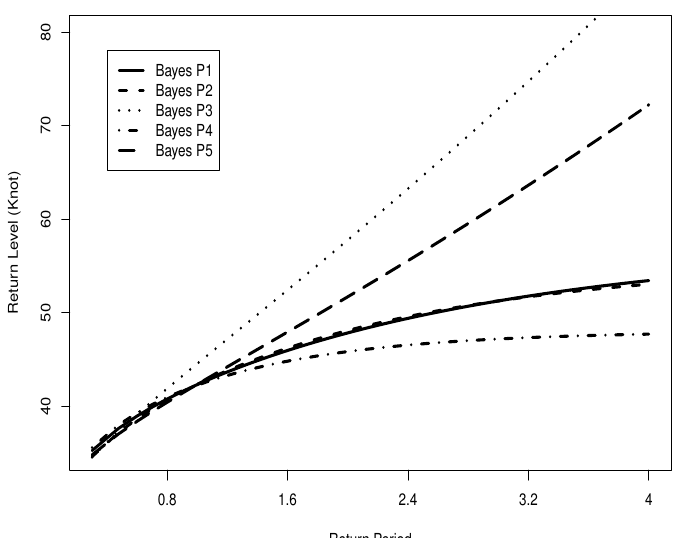
Figure 10. Predictive return levels against a log five priors (P1 to P5) considered in the Section 4.2 for the annual maximum wind speeds at Udon Thani, Thailand.